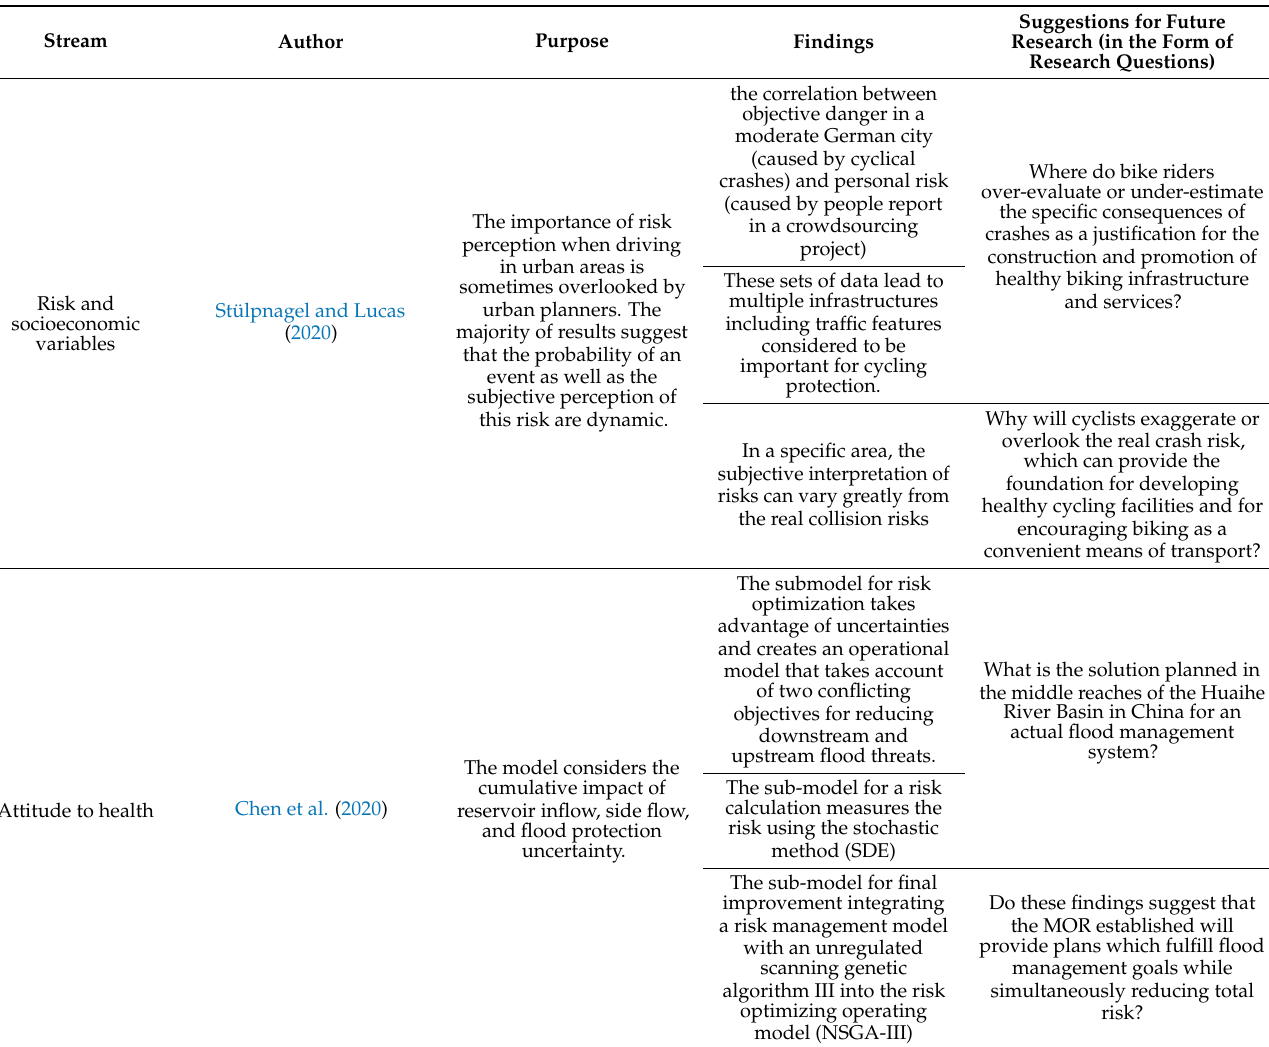
Table 8. Cluster